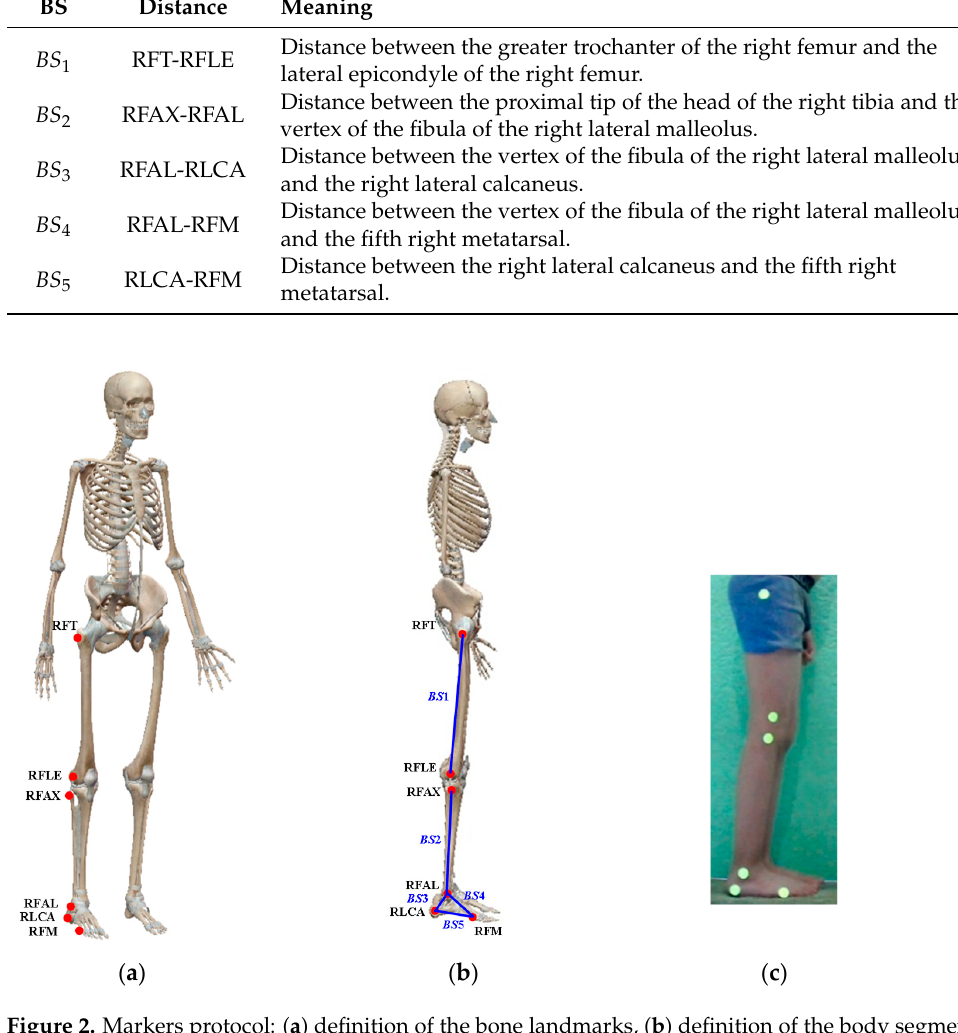
Table 2. Definition of the anthropometric measurements of the body segments (BSs).